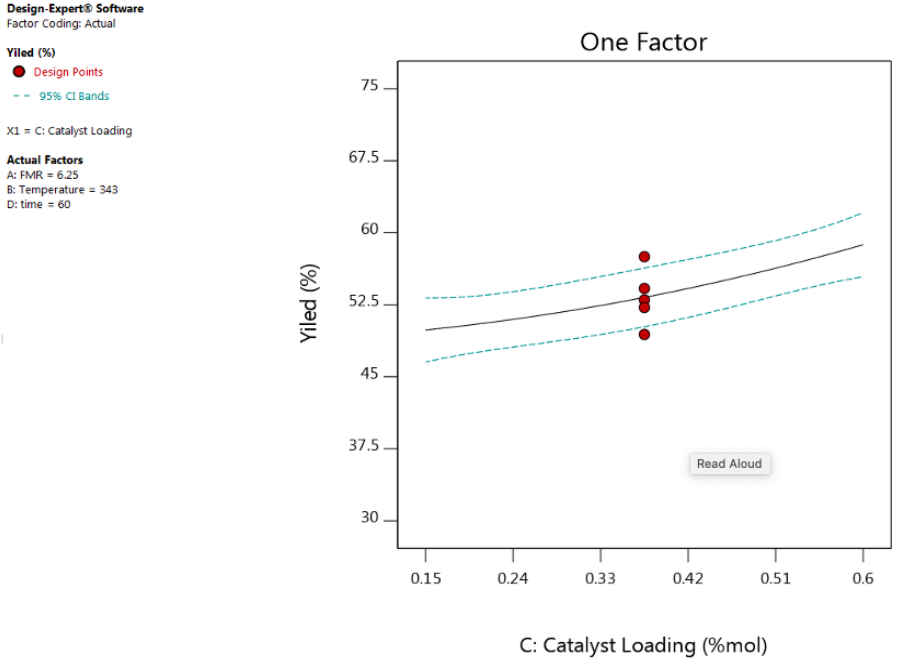
Figure 9. The effect of catalyst loading on the yield of 1,2-epoxy-5-hexene.